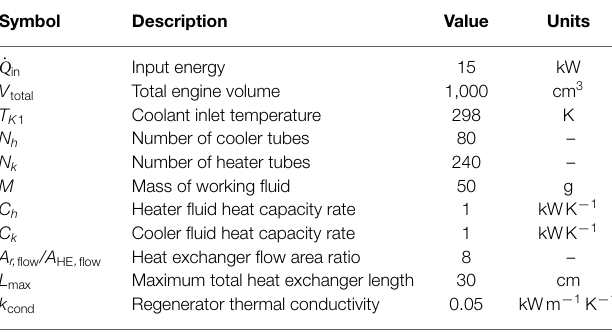
TABLE 1 | Table of fixed parameters.